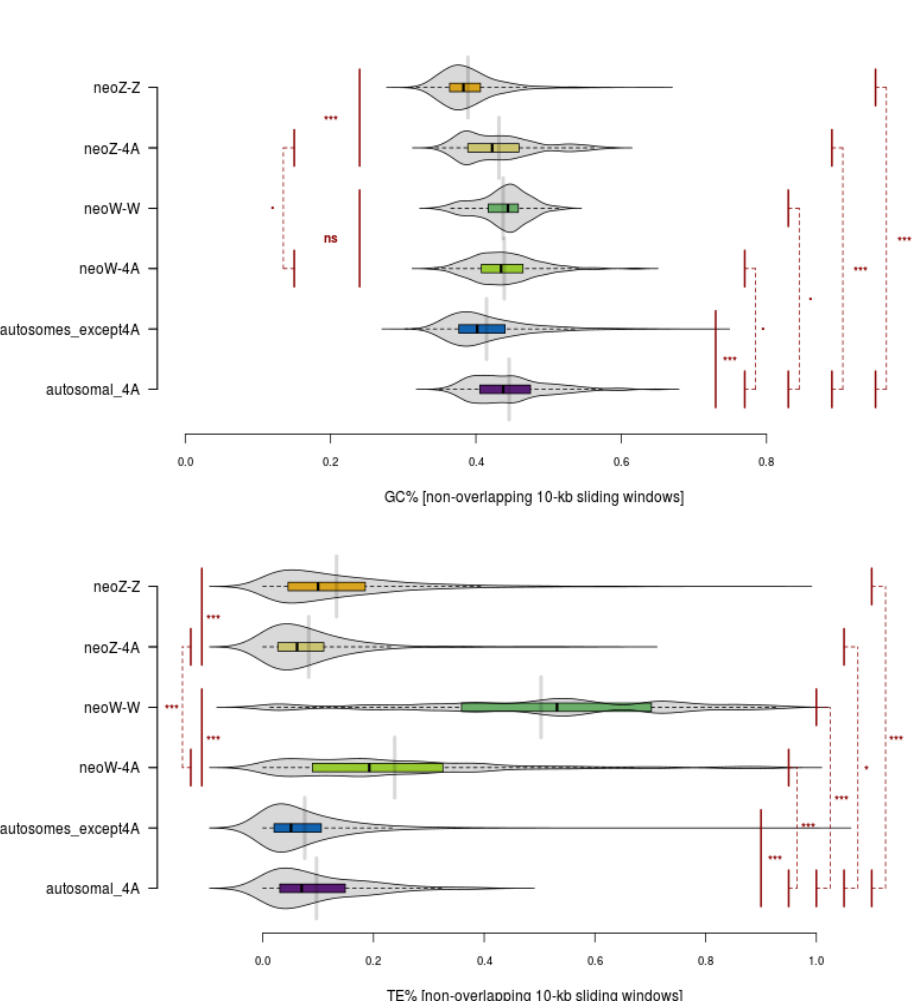
Figure 8. Variation in GC (top) and TE (below) contents between chromosomes. GC and TE contents were estimated along the whole genome using non-overlapping 10-kb sliding windows. Means were compared using t-tests (pairwise comparisons between chromosome sets, without corrections for multiple testing). Thresholds: . < 0.1, * < 0.05, ** < 0.01, *** < 0.001